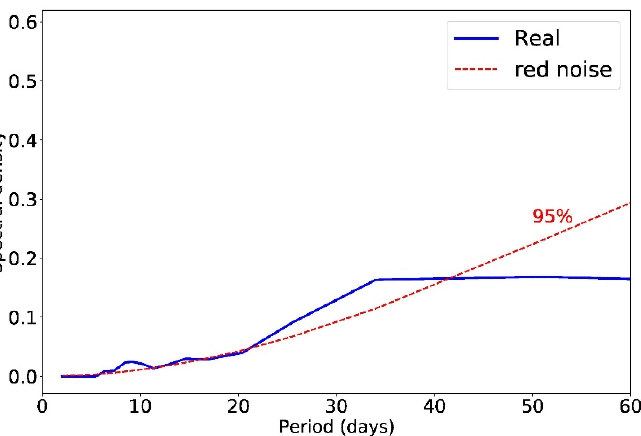
Figure 8. Power spectrum analysis of smoothed zonal wind on 850 hPa in the northern South China Sea (105~115° E, 12~20° N) during May–September 2014 (the red dotted line indicates 95% confidence).